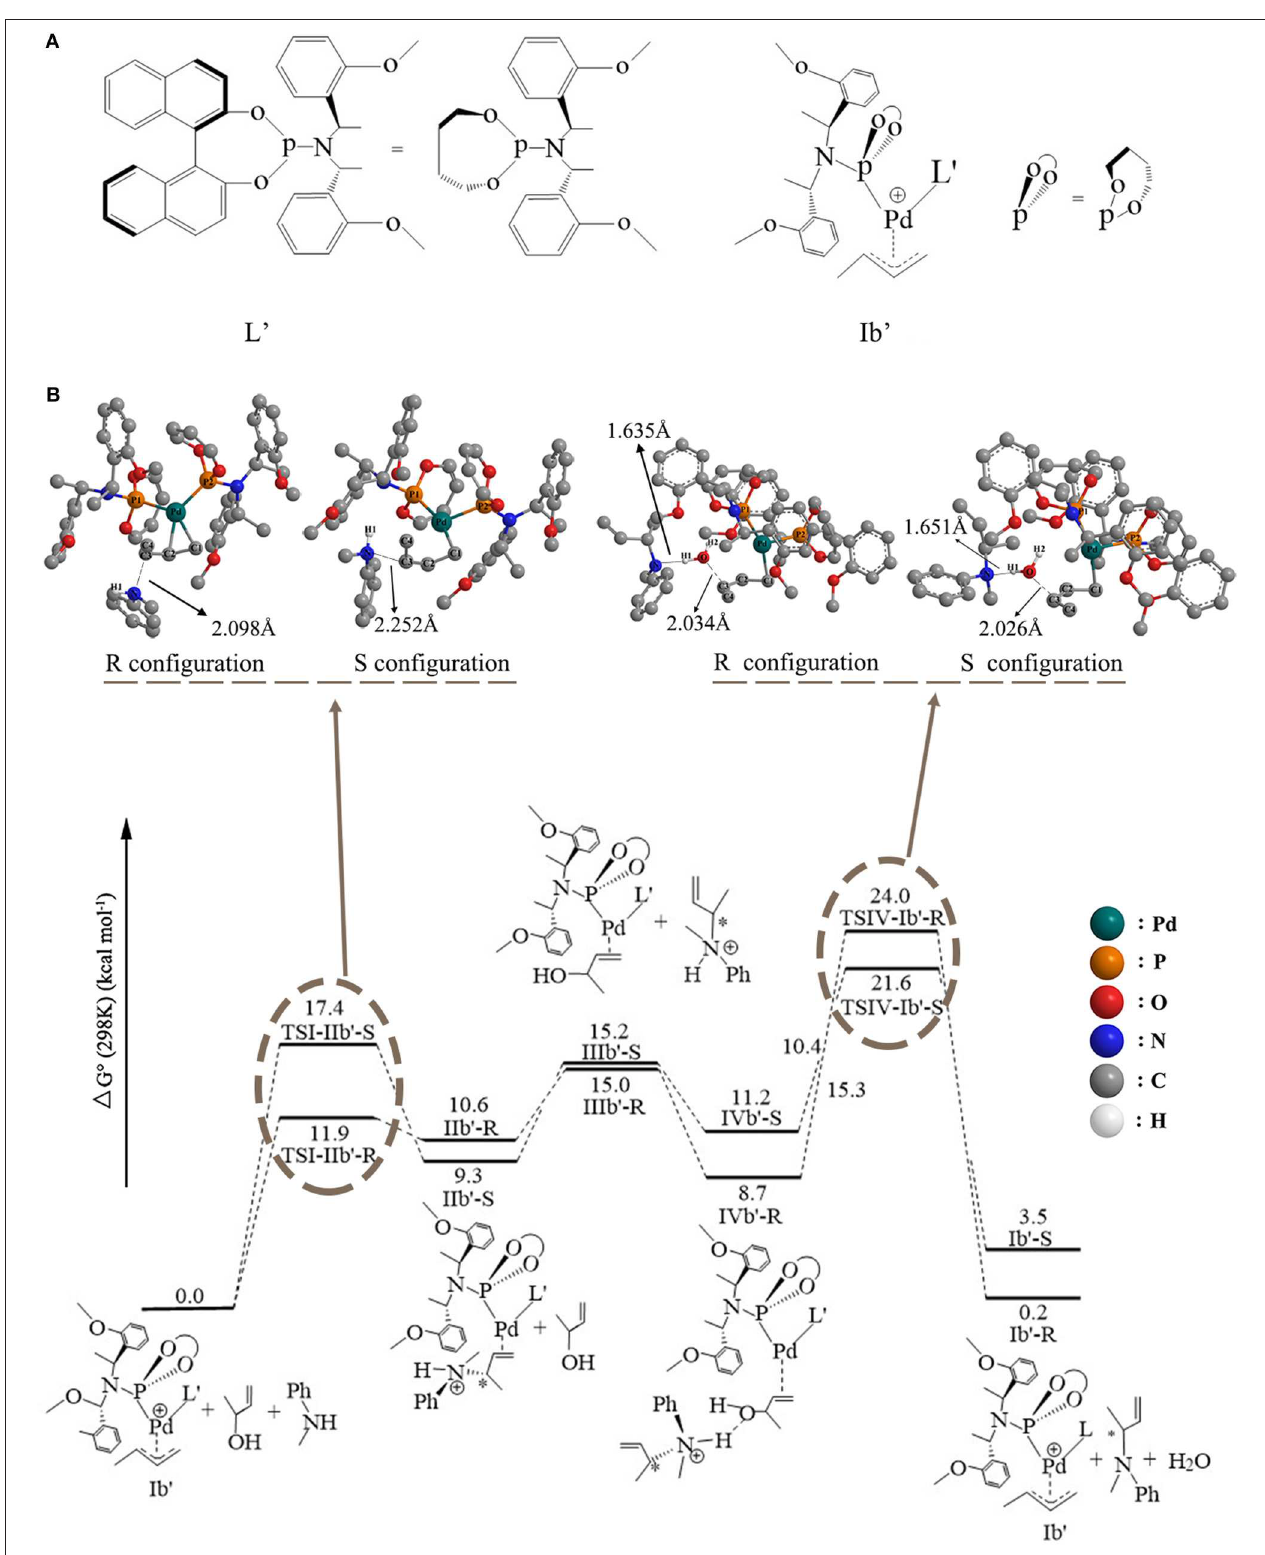
FIGURE 7 | (A) The structure of phosphoramidite ligand ( L ′ ). (B) The overall free energetic profiles and structures for the 3-butene-2-ol amination reaction process in THF catalyzed by phosphoramidite Pd-L ′ .